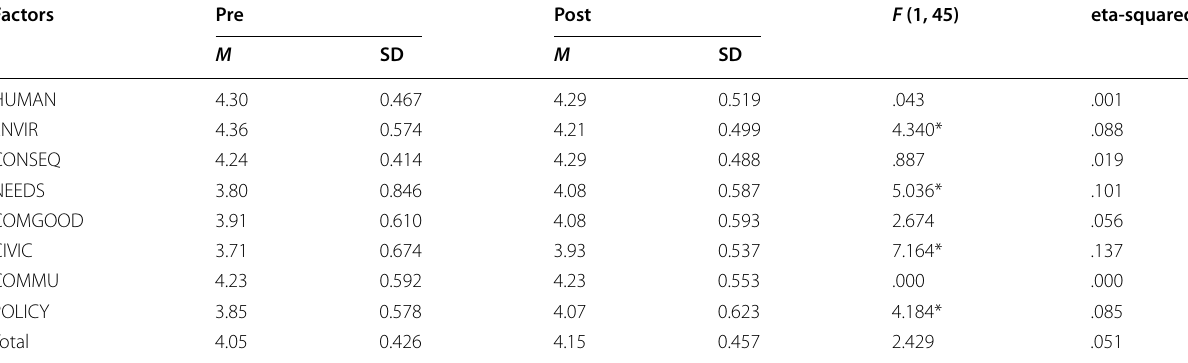
Table 3 Repeated measures ANOVA for VSRoSE